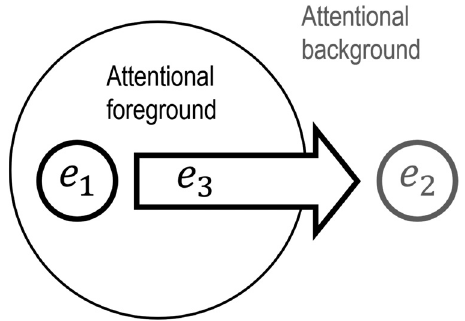
Figure 2: e 3 denotes an experienced connection between e 1 and e 2 . e 3 is itself part of the attentional